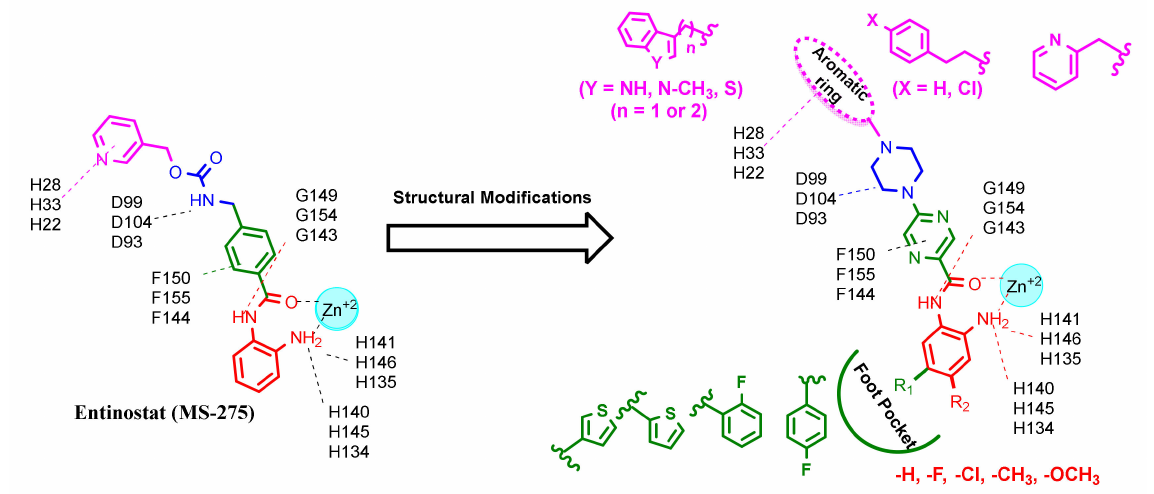
Figure 2. Structural modifications of Entinostat (MS-275) based on its interaction with the active site of HDAC 1 (red amino acid labels), HDAC 2 (blue amino acid labels) and HDAC 3 (green amino acid labels) subtypes to design novel compounds with different substitutions to obtain full SAR